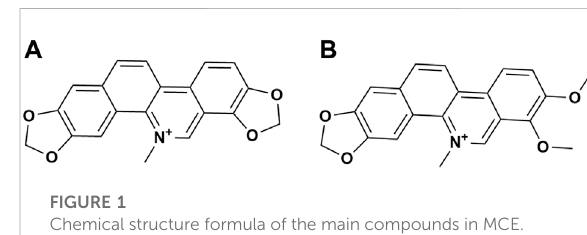
FIGURE 1 Chemical structure formula of the main compounds in MCE. (A) Sanguinarine; (B) Chelerythrine.